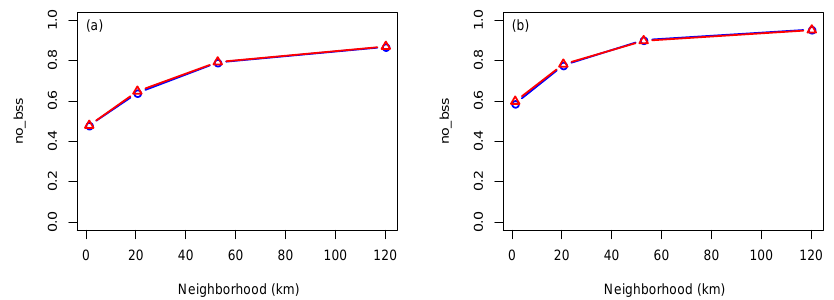
Figure 5. Neighbourhood observation Brier skill score for precipitation between 12:00 and 18:00UTC over the period 6 January–6 Febru- ary 2015, for REF (blue circles) and FCI (red triangles): (a) threshold 2mm; (b) threshold 10mm.